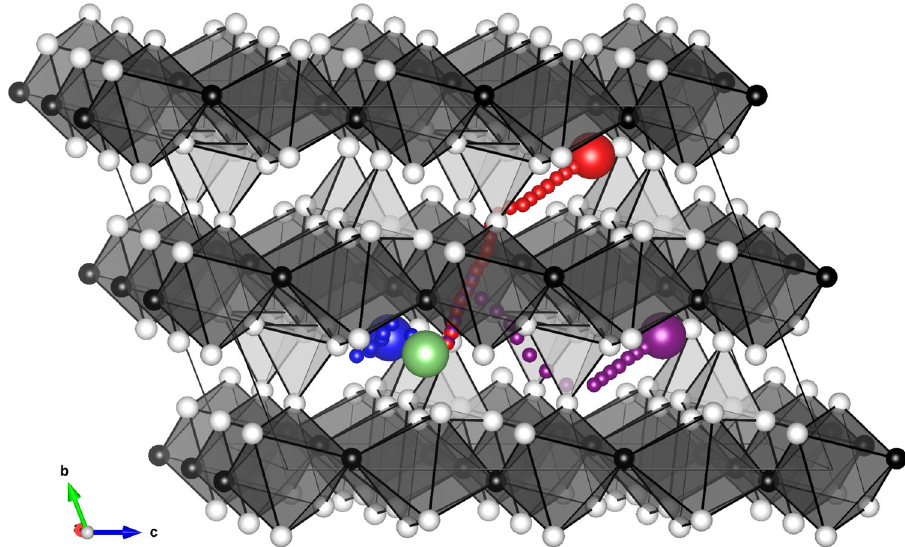
Fig. 1 Lithium diffusion paths projected onto a 2 × 2 × 2 supercell of FeSO 4 F. Elements are represented by white spheres (oxygen), black spheres ( fl uorine), dark gray octahedra (iron), and light gray tetrahedra (sulfur). The small red spheres represent the lithium diffusion path in the [111] direction, from the large green sphere (initial lithium site) to the large red sphere ( fi nal lithium site). The diffusion paths in the [101] and [100] directions are represented by purple and blue spheres, respectively. The fi gure is drawn using the VESTA visualization package 31